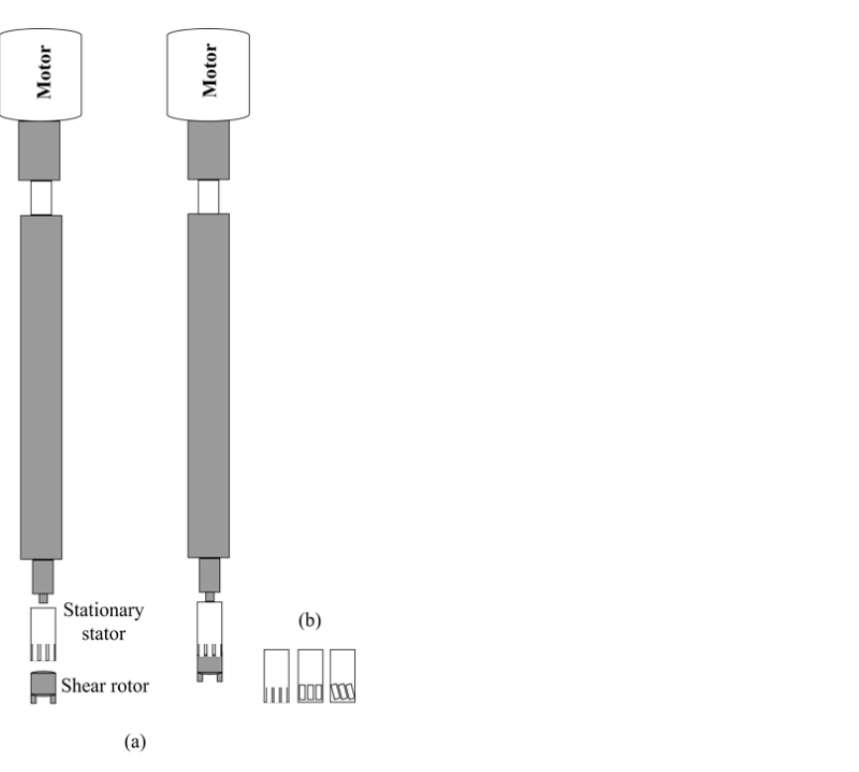
Figure 5. Schematic representation of the rotor-stator assembly of a high shear homogenizer type of disperser ( a ) before and after assembly; ( b ) different types of stators.